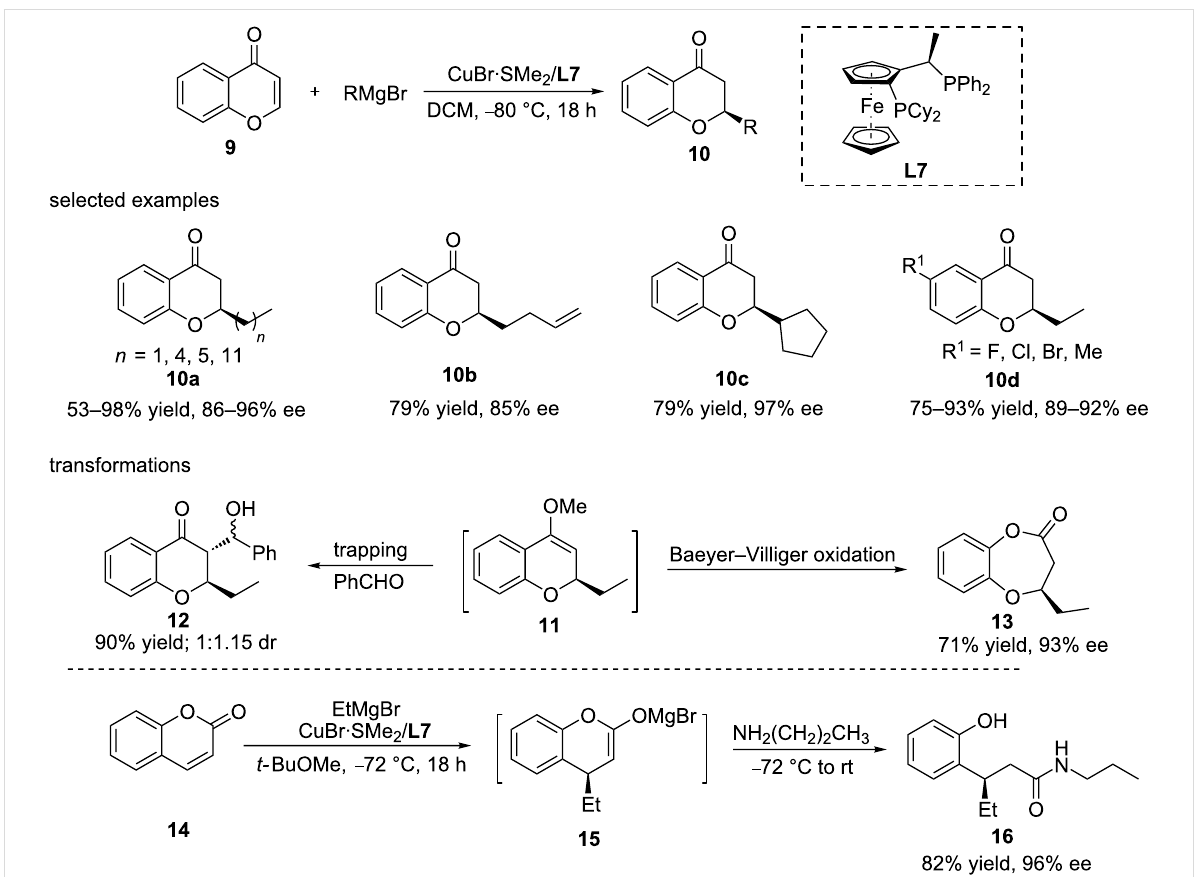
Scheme 5: Copper-catalysed ACA of Grignard reagents to chromones and coumarins and further derivatisation of the corresponding